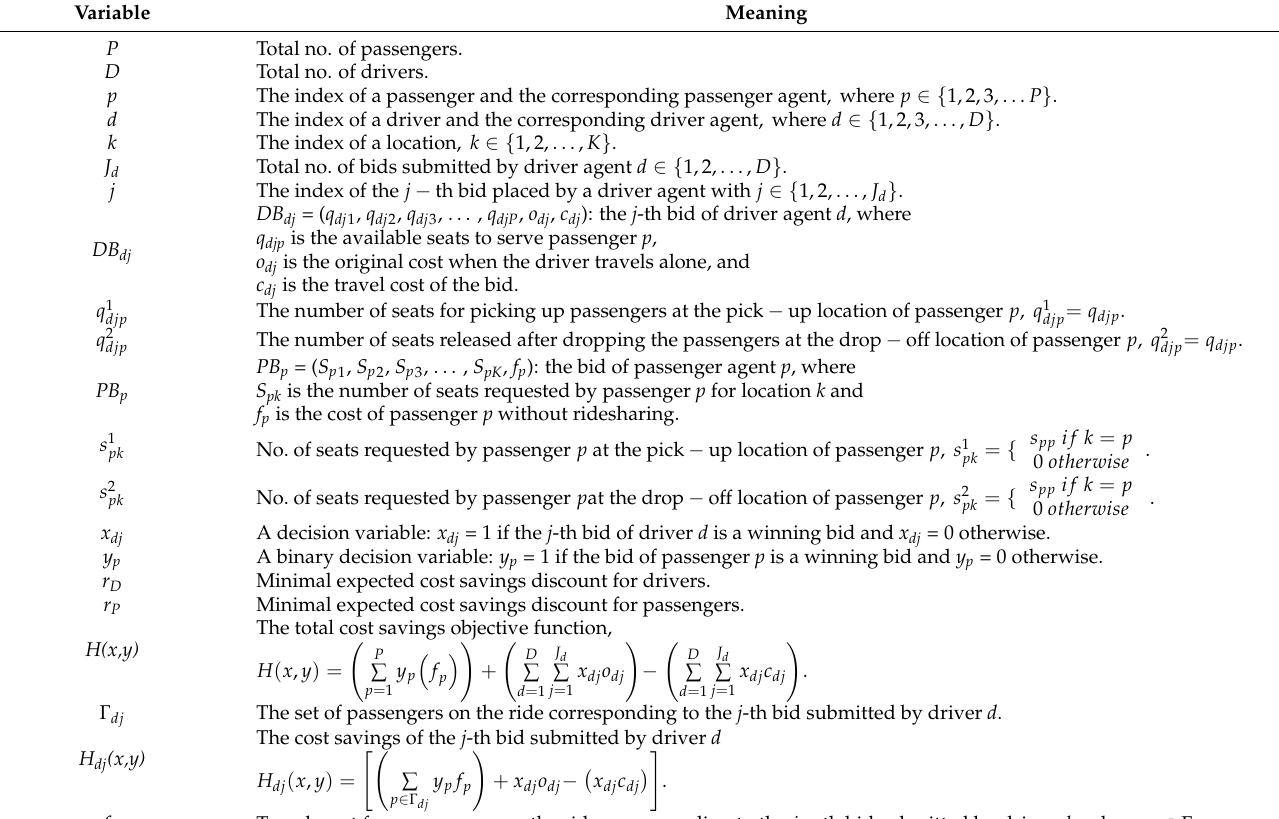
Table 1. Notations of symbols, variables, and